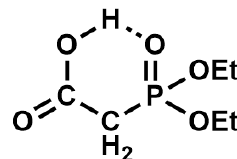
Figure 2. Internal hydrogen bonding in diethyl carboxyphosphonate decreases P=O oxygen nucle- ophilicity, leading to decreased silyldealkylation reactivity under MW-BTMS.